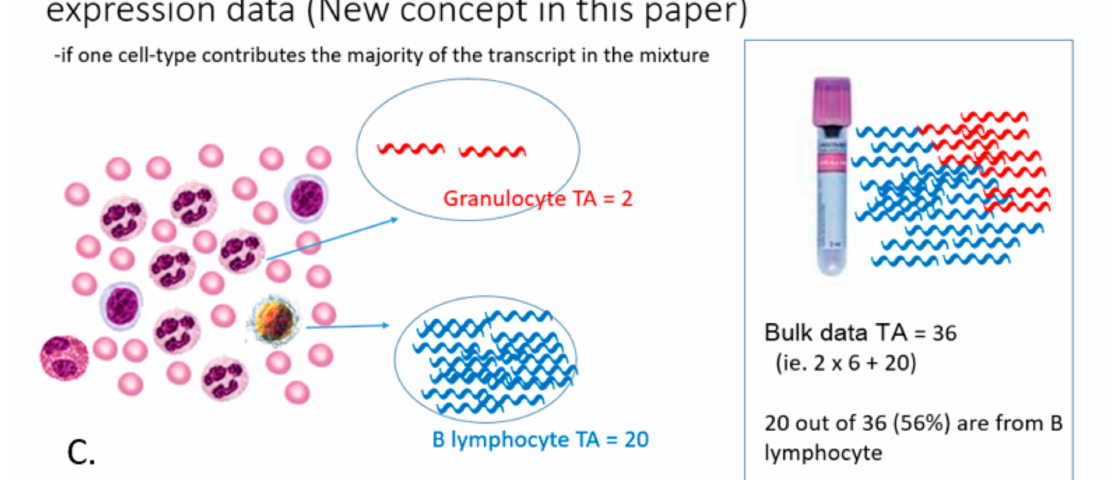
Figure 1. ( A ) Cell-type origin information is lost in bulk gene expression data. ( B ) The conventional concept of cell-type- specific genes are those genes exclusively produced by one particular cell-type. Such genes would be few in number. ( C ) Our new concept: Cell-type informative genes are predominantly expressed by a single cell-type, which is the sole major contributor (>50%) of gene transcripts in a cell-mixture sample (e.g., B lymphocyte in the figure). Transcript symbols produced by various cell-types are colored for presentation purposes only (Red for granulocyte produced transcripts and blue for B-lymphocyte produced transcripts); the transcripts are, in fact,